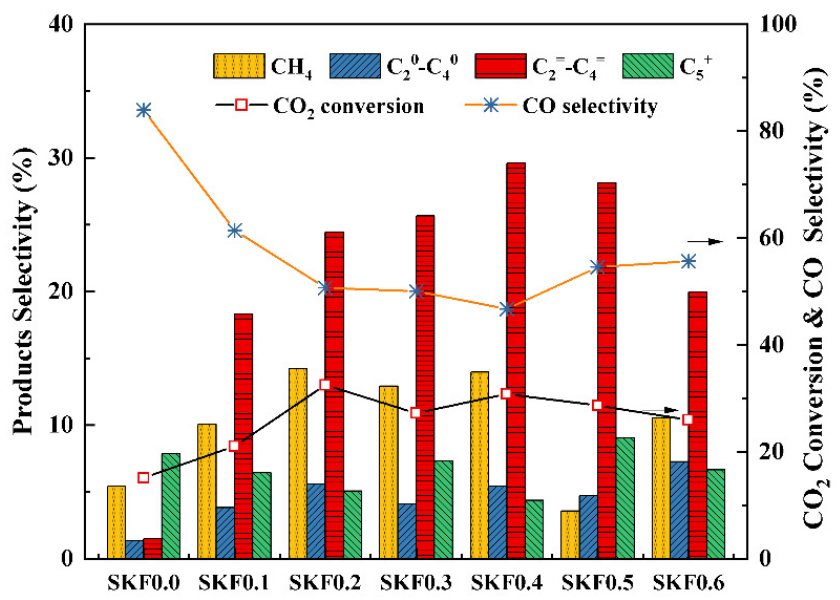
Figure 6. CO 2 conversion and product distribution over SKFx catalysts (reaction conditions: H 2 /CO 2 = 3/1, 350 °C, 1.0 MPa, GHSV = 7200 mL · gcat · − 1 · h − 1 ).